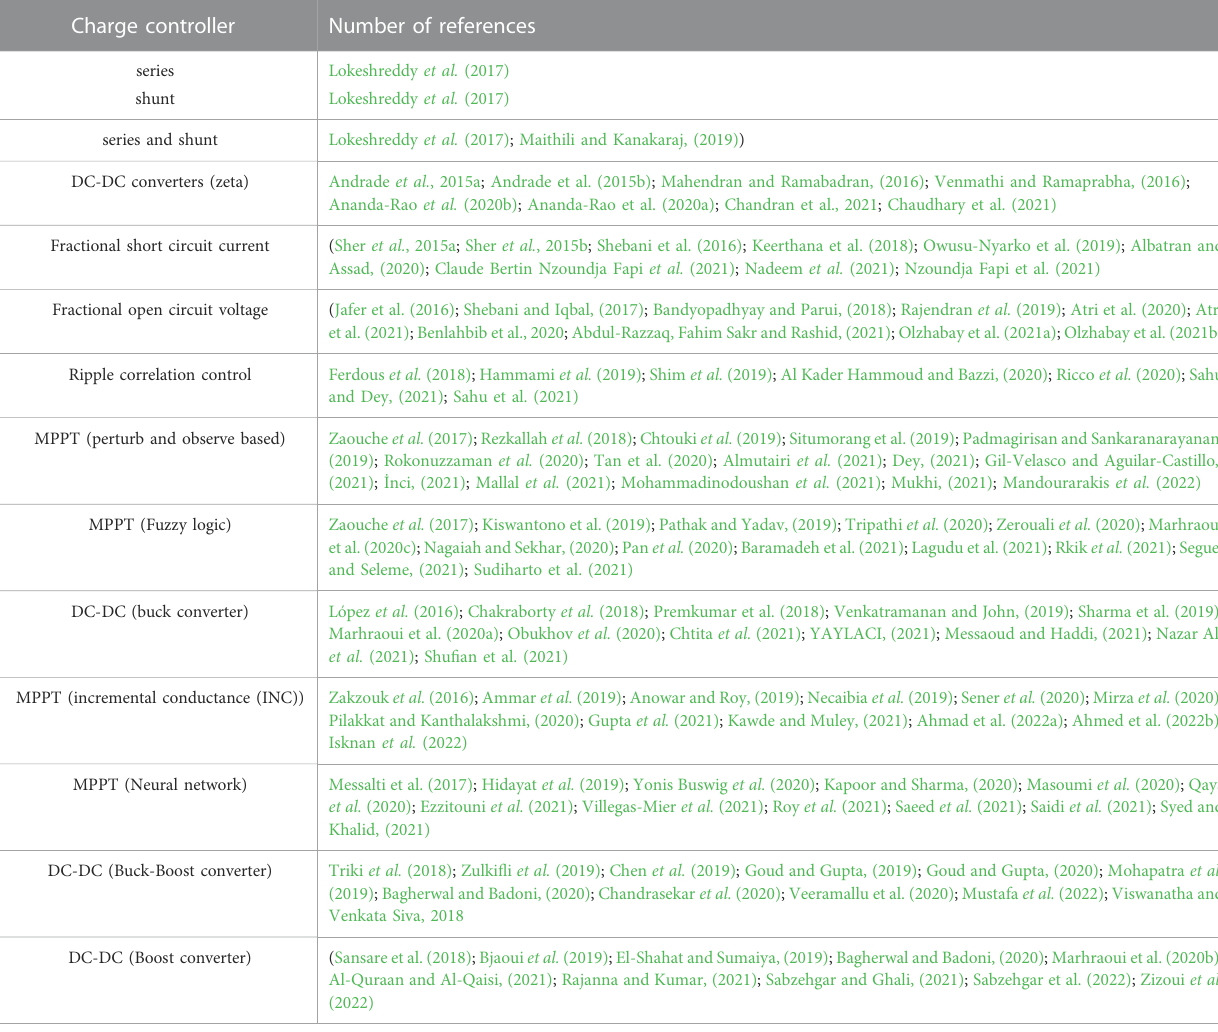
TABLE 3 The reference table according to the classi fi cation of PV-battery charge controller systems. Charge